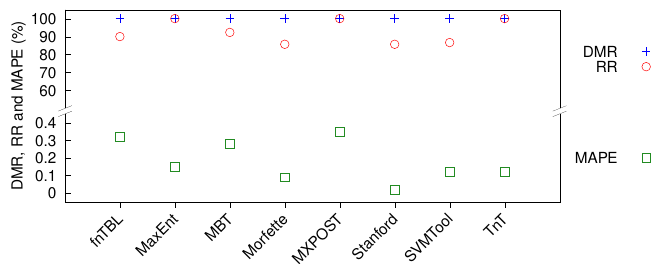
Figure 4. MAPE s, RR s and DMR s for runs.